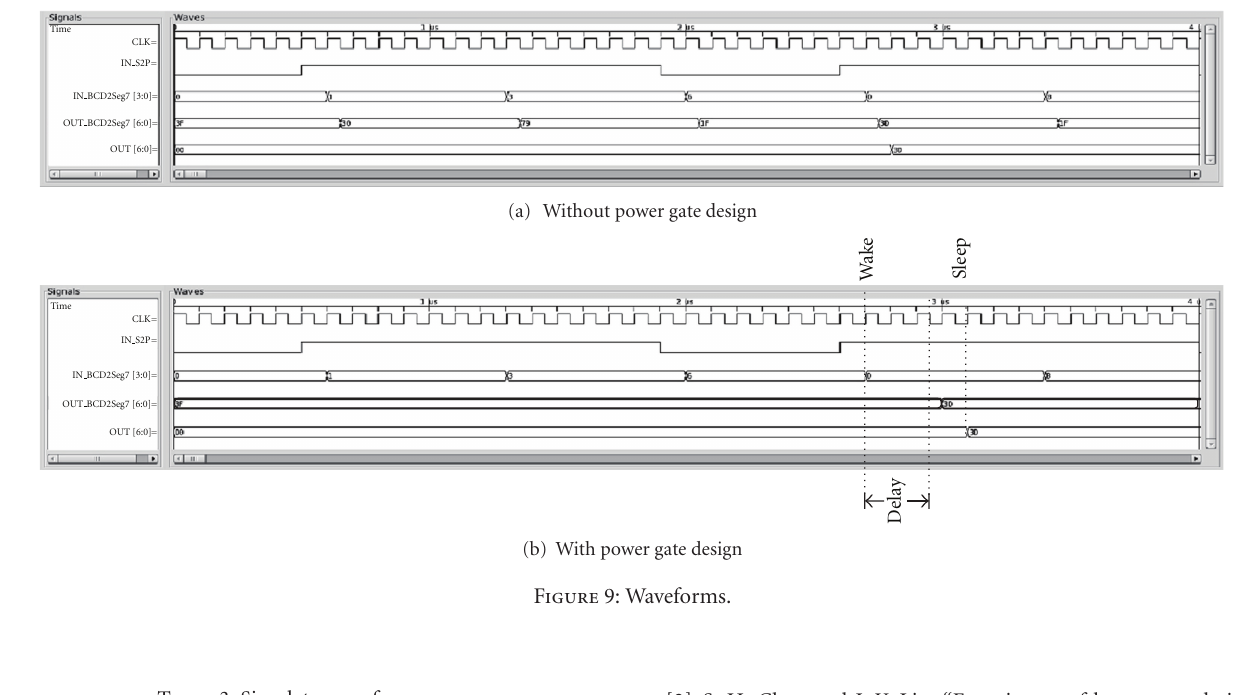
Table 3: Simulators